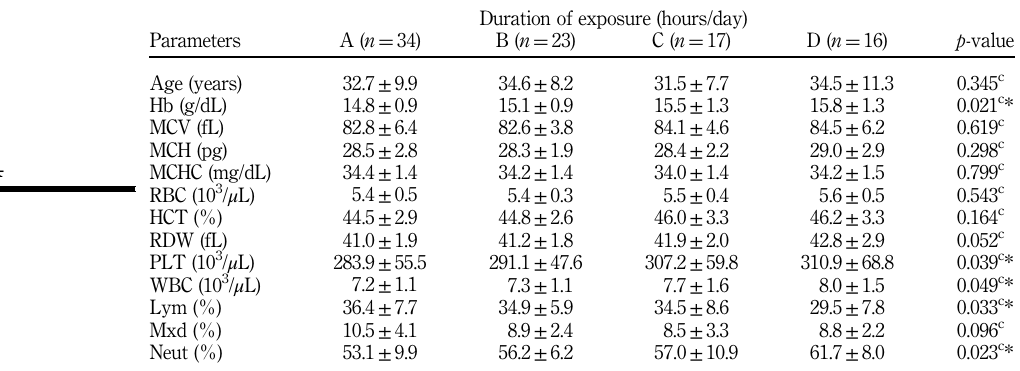
Table II. Hematological parameters of study groups based on exposure